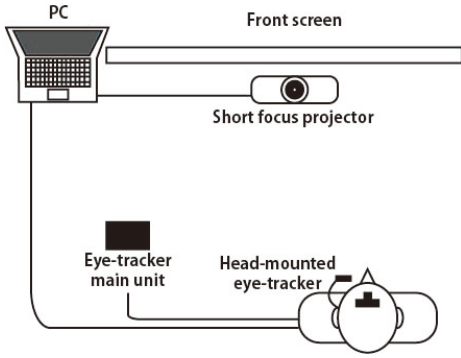
Figure 1: Overview of the experimental apparatus.